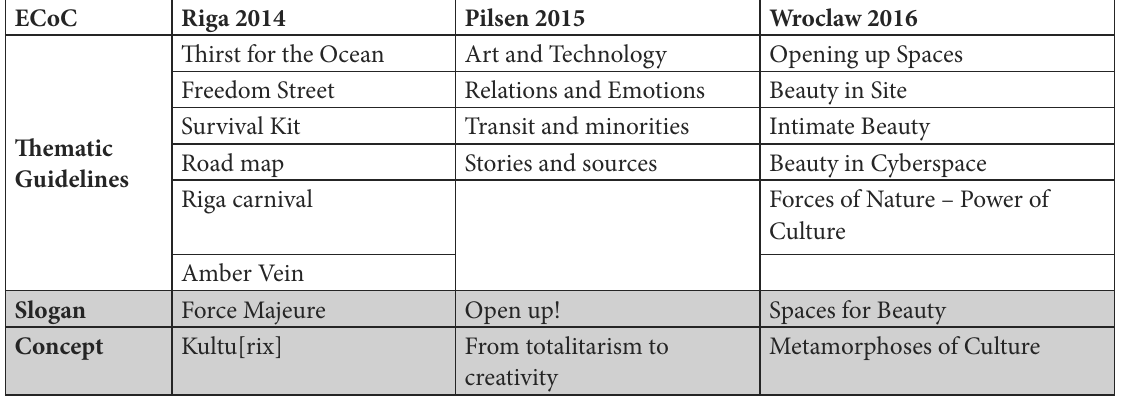
Table 1. ECoC - thematic guidelines, slogan and concept